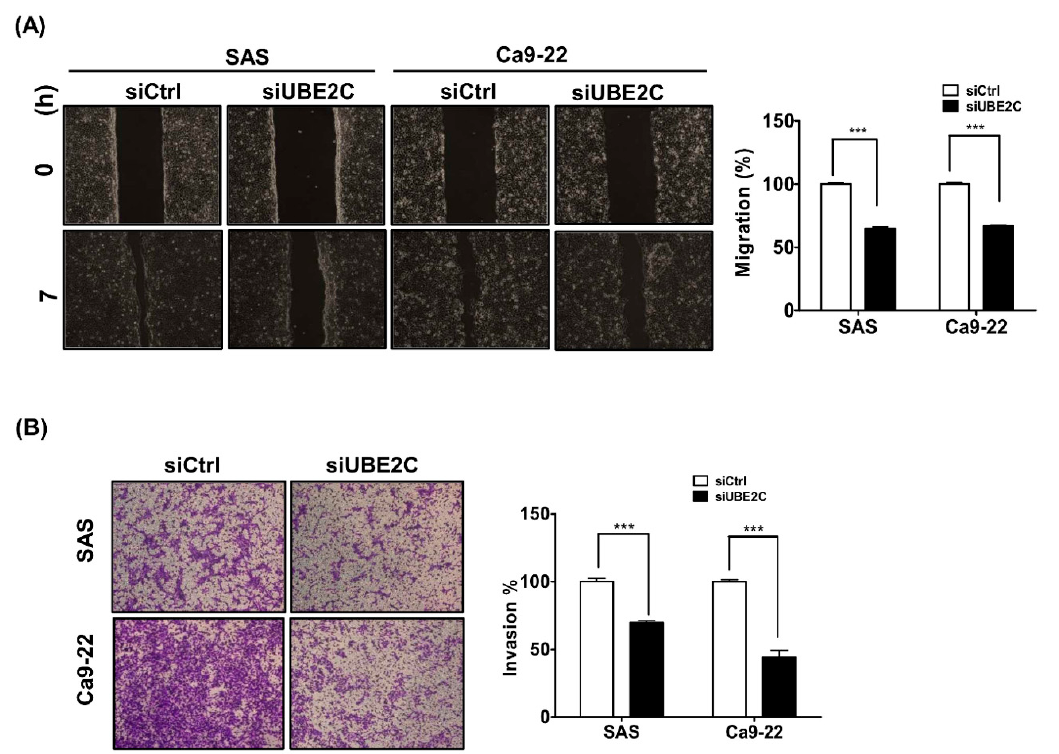
Figure 3. Cell migration and invasion in UBE2C-knockdown SAS and Ca9-22 cells. ( A ) Cells were transfected with scrambled siRNA (5 nM, siCtrl) or siRNAs against UBE2C (5 nM, siUBE2C) for 7 h and then their migration was assessed by wound–healing assay. ( B ) The invasion of cells transfected with scrambled siRNA (5 nM, siCtrl) or siRNAs against UBE2C (5 nM, siUBE2C) for 24 h was measured by transwell invasion assay. The quantitative results are expressed as the mean ± SD from three independent experiments. * p < 0.05, ** p < 0.01, *** p < 0.001 vs. nontargeting control siRNA (siCtrl).